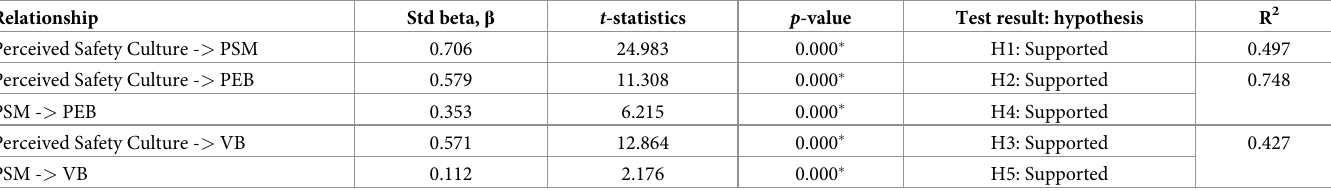
Table 5. Results of hypothesis